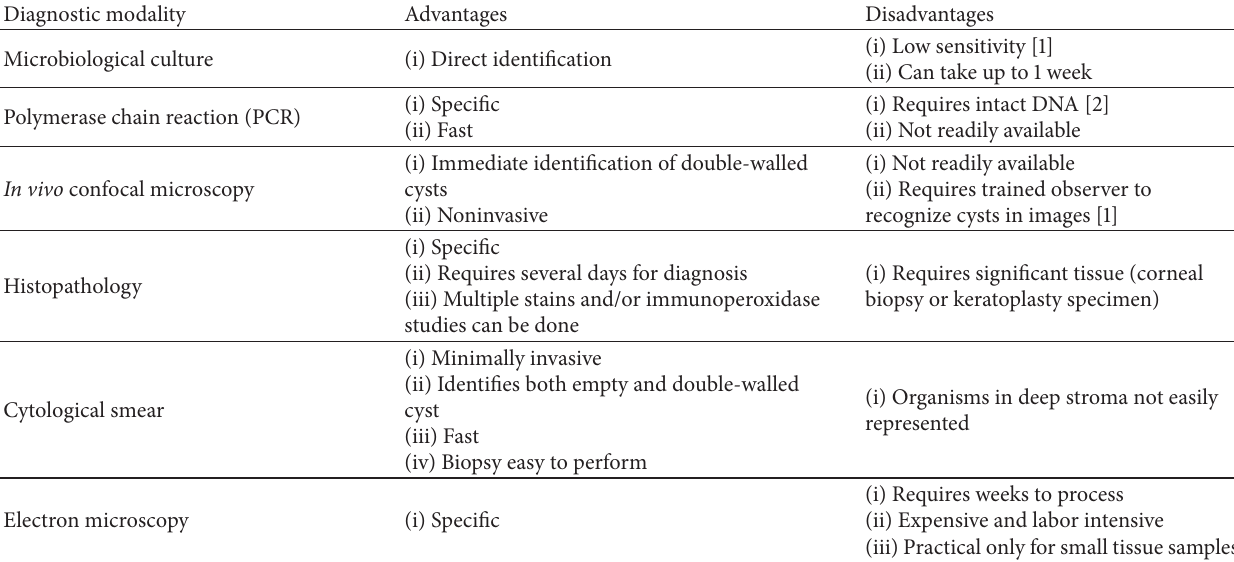
Table 1: Comparison of diagnostic approaches for Acanthamoeba